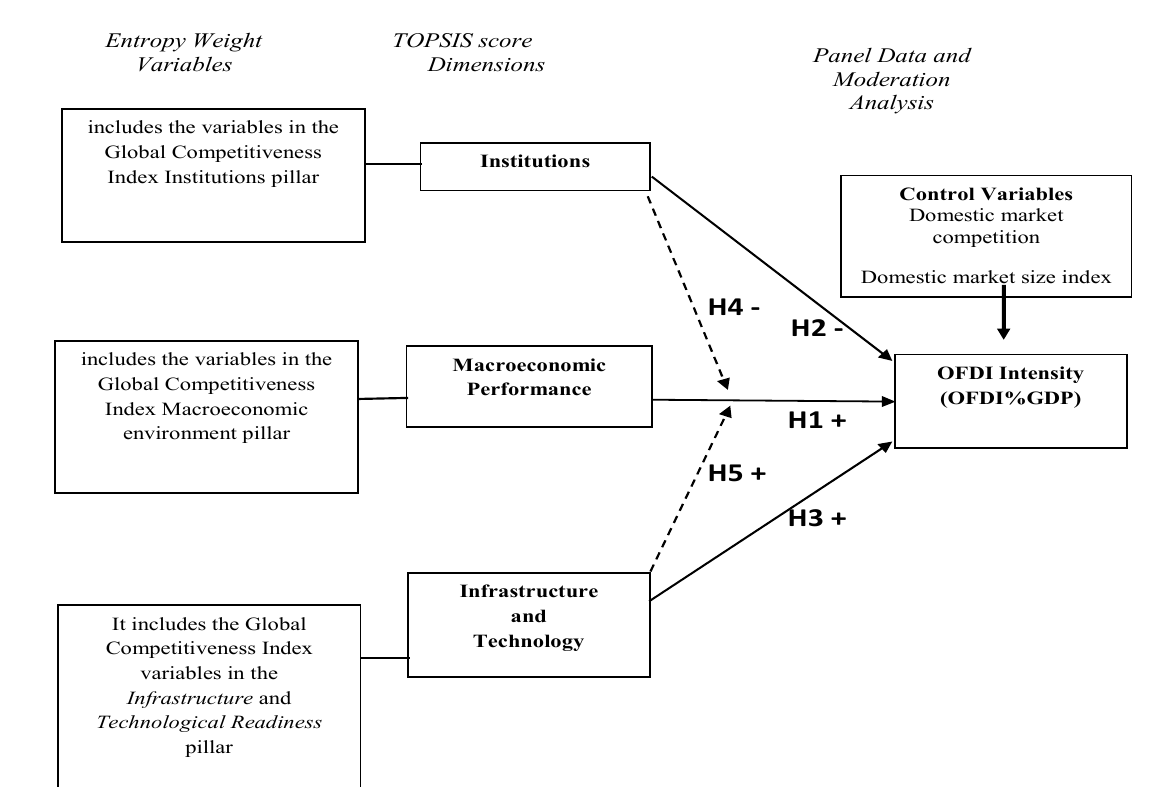
Figure 2. An entropy-based TOPSIS and panel data approach for the determinants of the OFDI intensity in LAC.